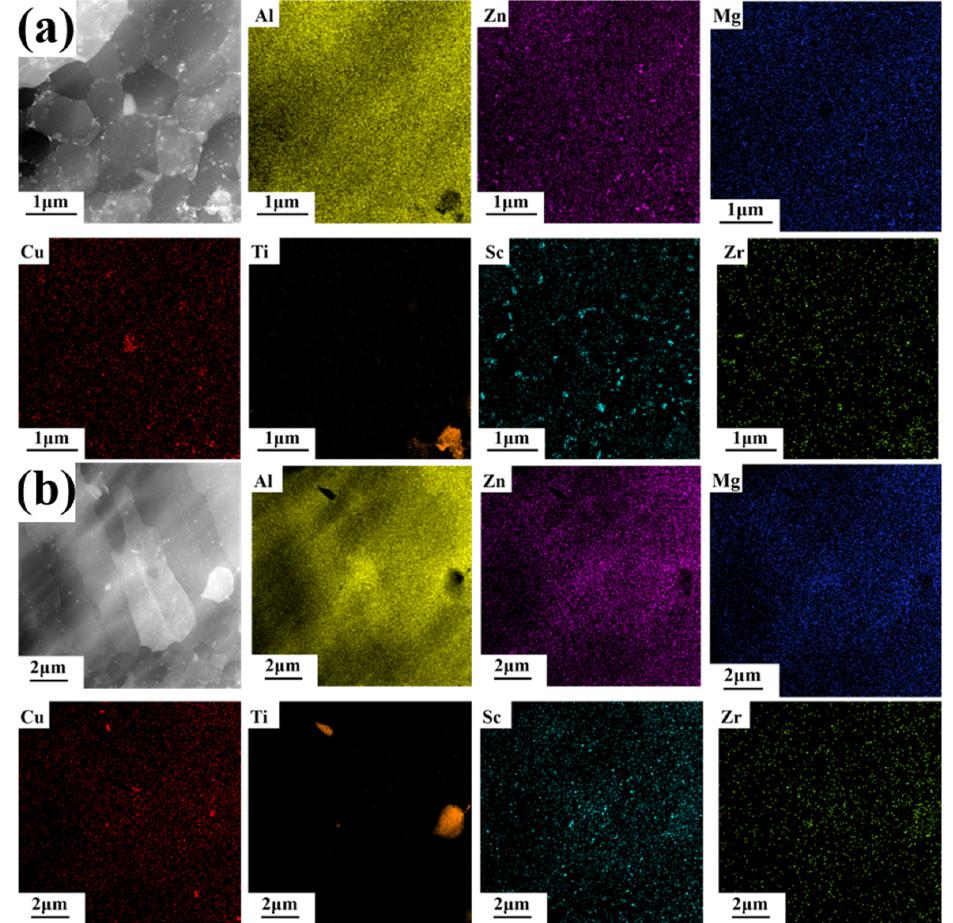
Figure 9. STEM HAADF images of SLM-fabricated TiB 2 /AlZnMgCu(Sc,Zr) composite heat-treated samples and corresponding EDX mapping of the solute elements (Al, Zn, Mg, Cu, Ti, Sc, Zr) ( a ) in the fine grain region and ( b ) in the columnar grain region.